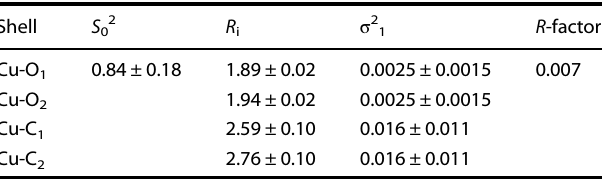
Fig. 6 Cyclic voltammetry analysis. Cyclic voltammograms of graphene-based catalysts in air- and N 2 -saturated 0.1 M KOH